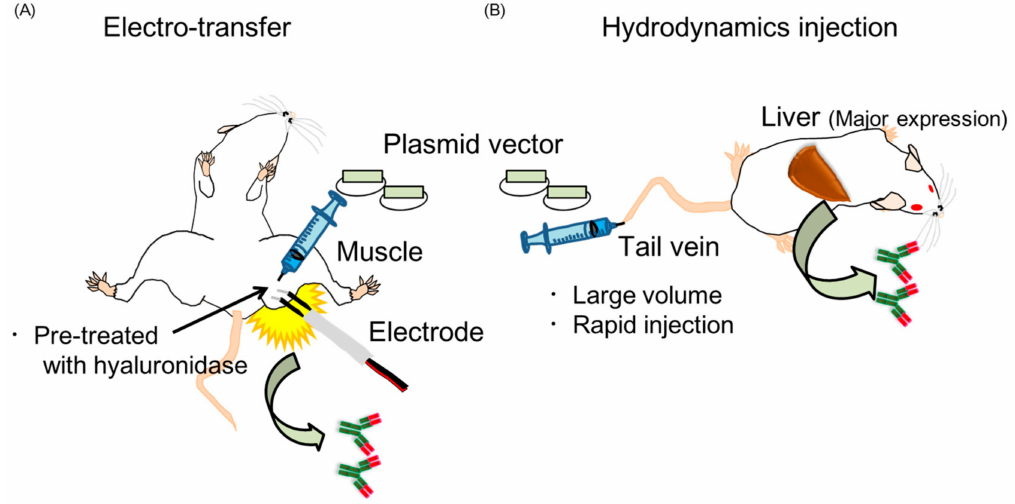
Figure 2. Scheme of electro-transfer ( A ) and hydrodynamics injection ( B